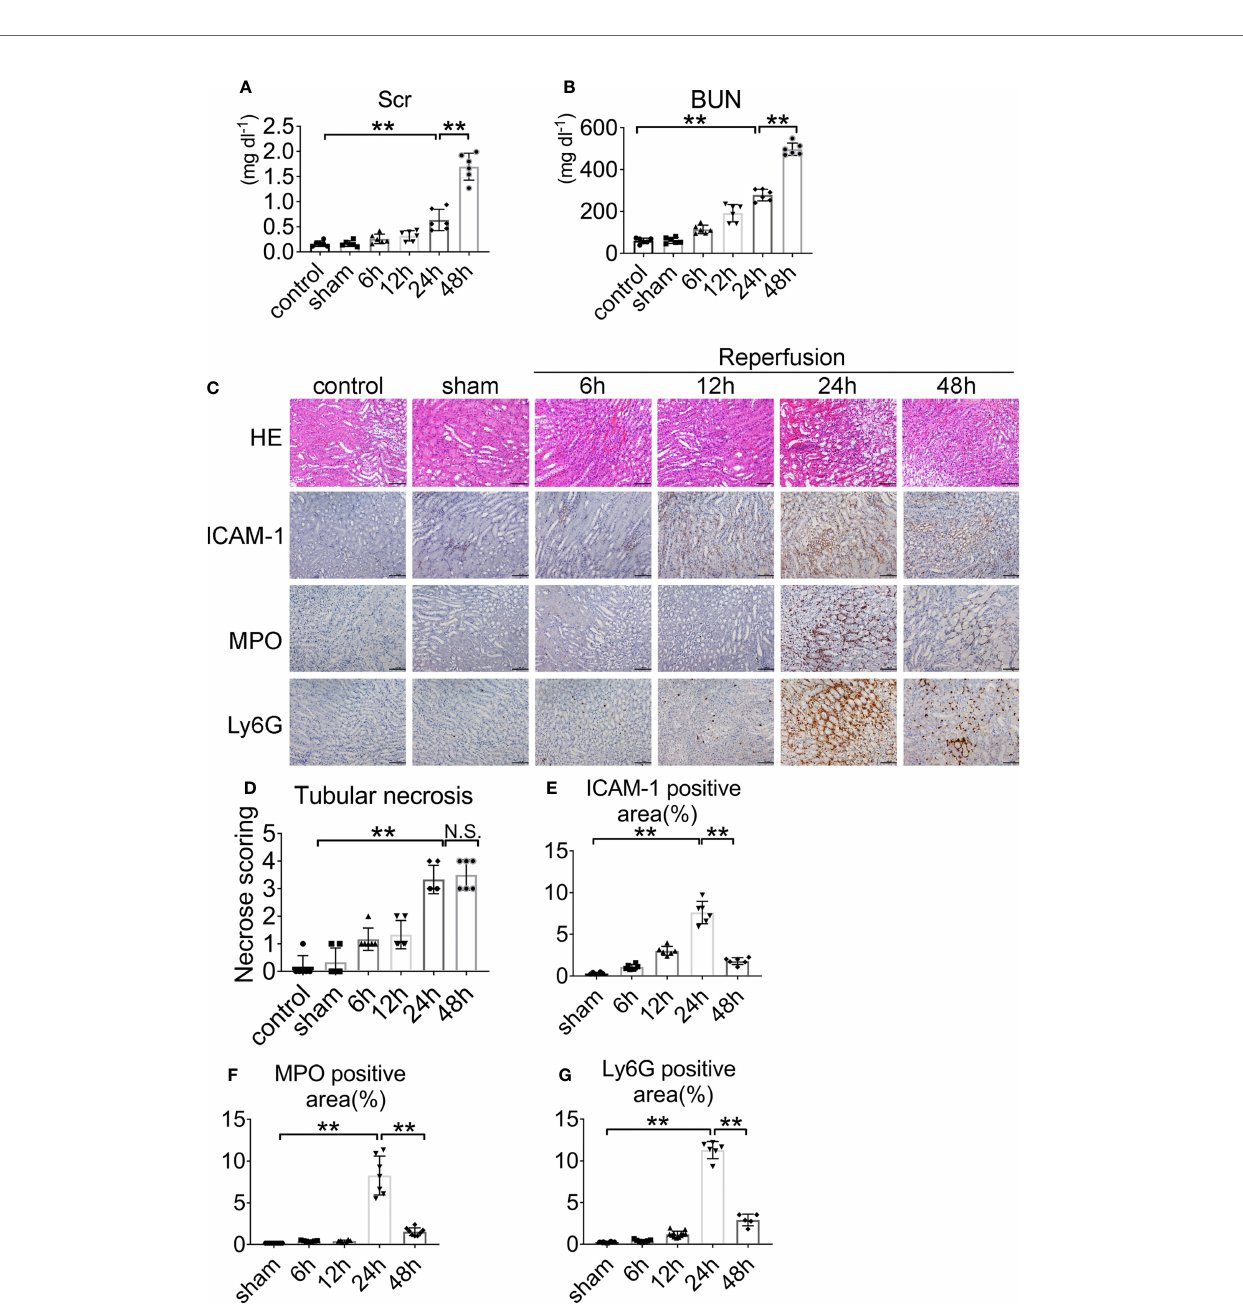
eosin (HE)-stained kidney sections from mice after IRI ( Figure 1D ). ICAM-1, MPO, and Ly6G proteins were measured in kidney tissue 6, 12, 24, and 48 h after reperfusion or sham surgery. At 24 h of renal reperfusion, the abundant